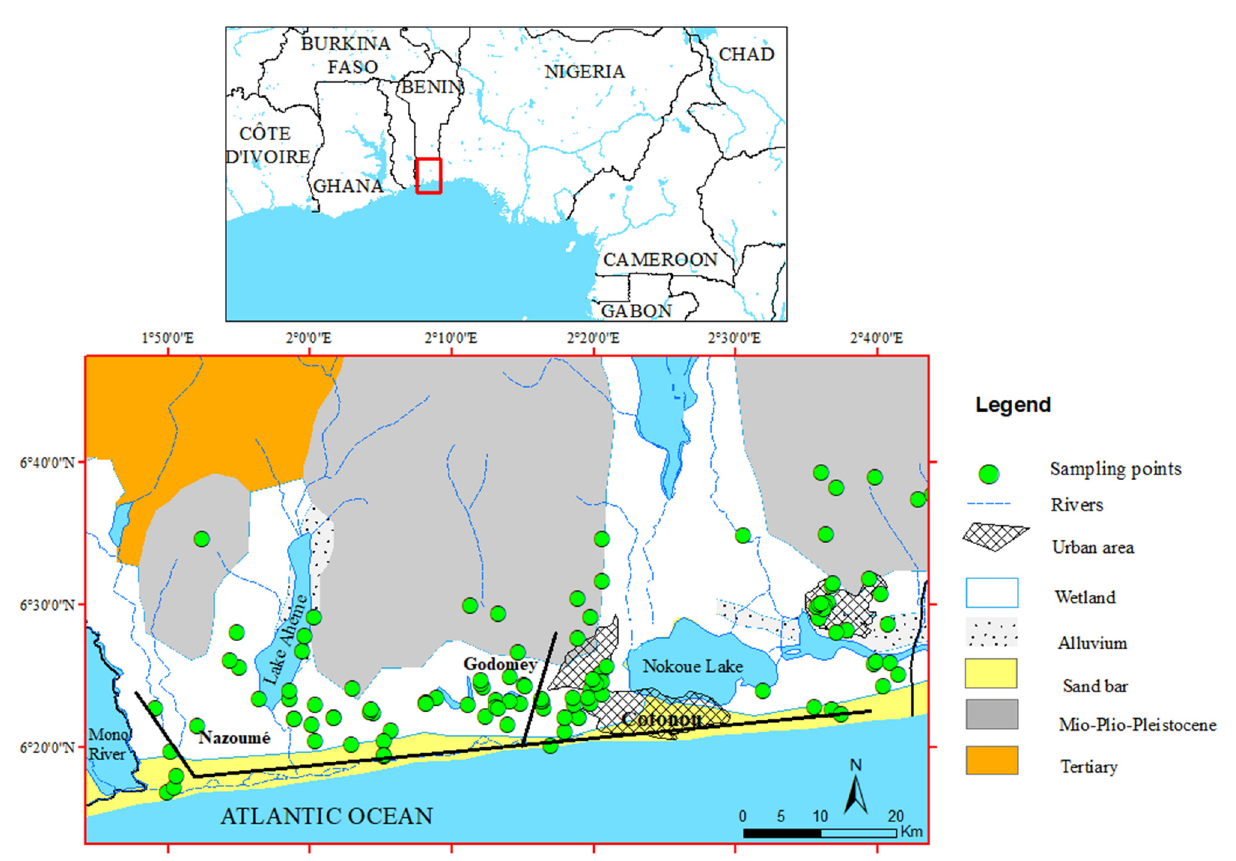
Figure 1. Location and geology of the study area with sampling points. The urban areas of Cotonou (the southernmost), Abomey-Calavi (north of Cotonou), and Porto-Novo (the easternmost) are also highlighted. Black straight lines represent cut line used later for geological cross sections.